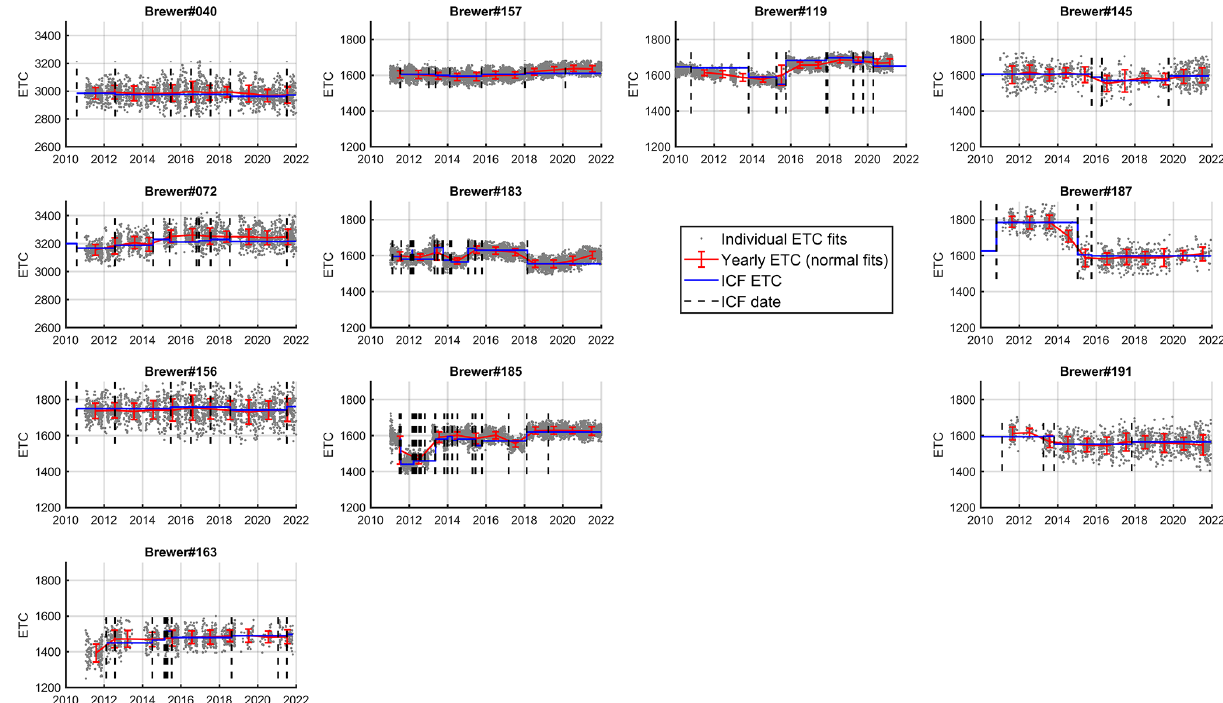
Figure 2. Long-term Langley fits of Brewer instruments from Arosa/Davos (Brewer instruments #040, #072, #156), Davos (Brewer #163), Izaña (#157, #183, #185), MLO (#119), and Toronto (#145, #187, #191). Gray dots are fitted ETCs for individual half-days, red lines are yearly mean values of these individual ETCs (error bars are 1 σ values), and blue lines are ETC values obtained from instrument calibration files (ICFs; validation periods are indicated as vertical dashed black